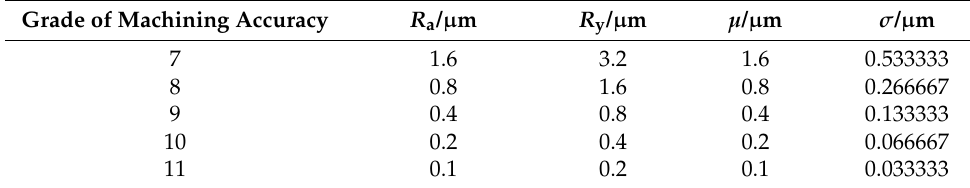
Table 1. Monte Carlo random normal distribution sampling parameters for sealing surface’s profile